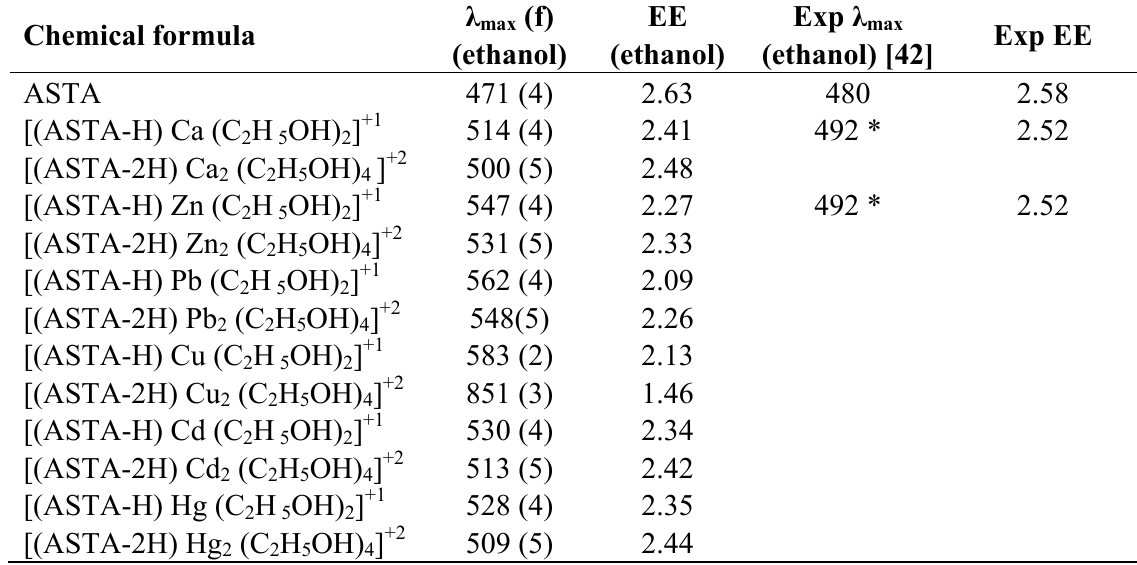
Table 2. UV/vis maximum absorption wavelength, λ